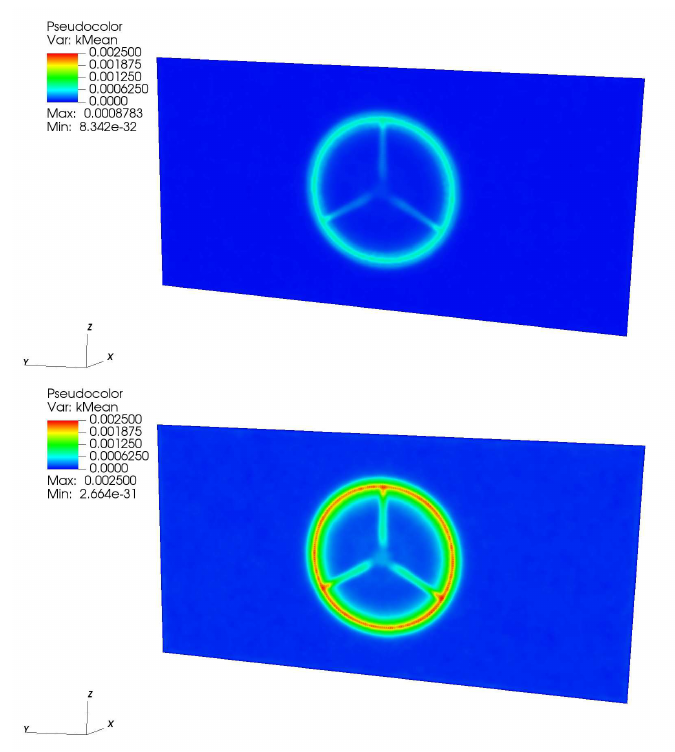
Figure 8. CFD Turbulent kinetic energy for ( top ) Uo = 0.6 m/s and ( bottom ) Uo = 1.0 m/s.